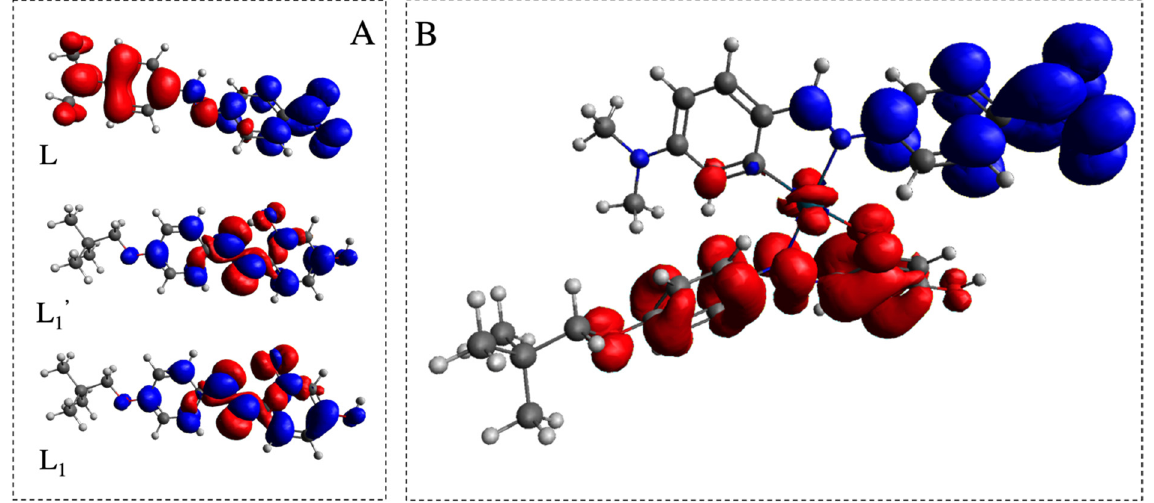
Figure 3. Isosurface plot of the differential electron density ρ diff for L, L1, and L1 ′ ( A ) and Pd1 ( B ). The isosurface plot is set to 0.01 |e|/a 03 isolevel density. The blue lobes are the positive values of the differential electron density ρ diff , the red lobes are the negative values.